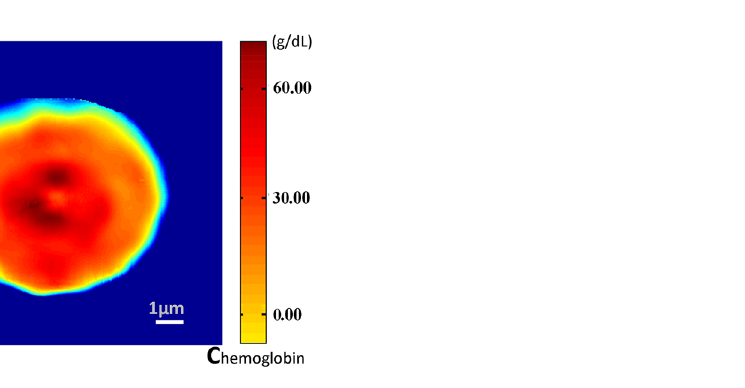
Figure 5. Refractive index and the corresponding hemoglobin concentration distribution of single red blood